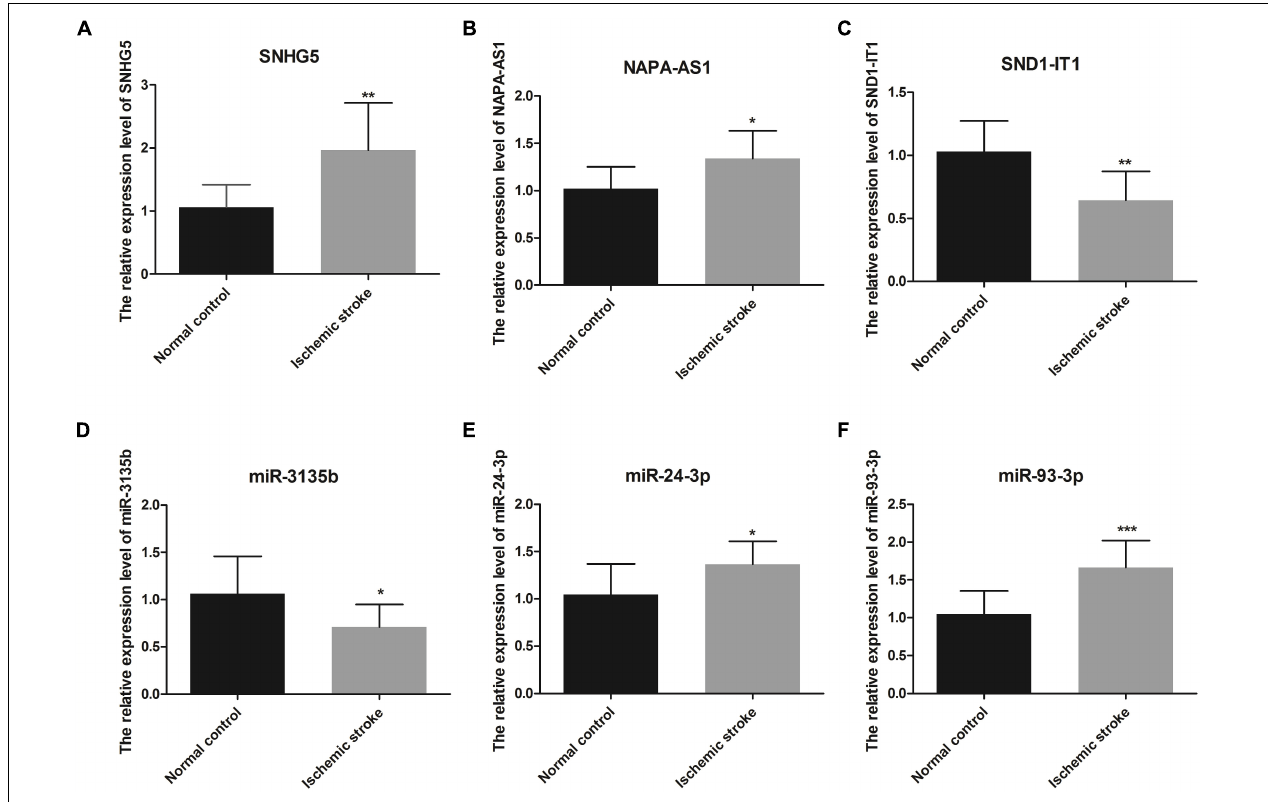
FIGURE 9 | The relative expression level of SNHG5 (A) , NAPA-AS1 (B) , SND1-IT1 (C) , miR-3135b (D) , miR-24-3p (E) , and miR-93-3p (F) . * represents p < 0.05, and ** represents p <